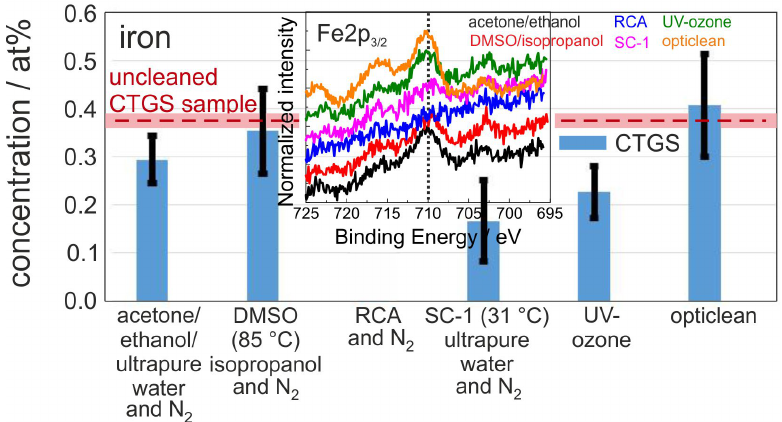
Figure 3. Mean value of iron concentration after the respective cleaning procedure measured with XPS (Al-source with neutralizer) on the CTGS surface. The red dashed line represents the mean iron values of the uncleaned CTGS reference samples of about 0.38 at %. The light red stripe indicates the corresponding standard deviation of 0.015 at %. For the Si reference, no Fe contamination was detected. The inset shows the normalized Fe2p 3/2 spectra of one set of samples. The black dotted line marks the theoretical position of the Fe2p 3/2